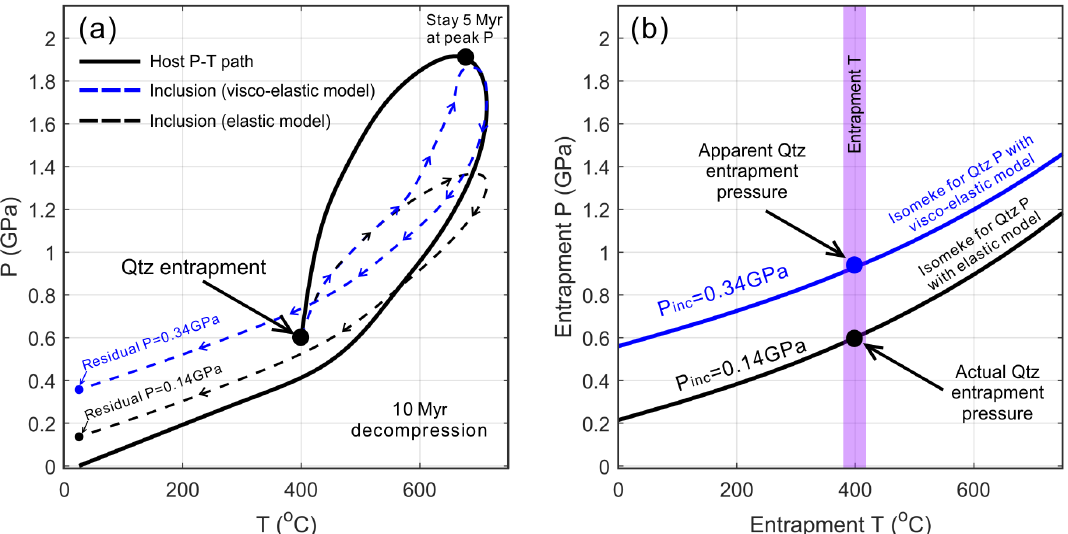
Figure 6. (a) Clockwise P – T path of inclusion (dashed curve) and host (solid curve). The dashed black curve shows the inclusion P – T path based on a pure elastic model, and the blue dashed curve is based on a visco-elastic model. The quartz inclusion is entrapped in almandine garnet at 400 ◦ C, 0.6GPa. The prograde P – T path lasts 5Myr, and the rock stays at peak P for 5Myr before the retrograde P – T path, which lasts 10Myr. The residual pressure preserved by the quartz inclusion that was subject to viscous relaxation is in fact higher than the elastic limit. Therefore, the apparent entrapment pressure, calculated using elastic isomeke, is higher than the actual entrapment pressure as shown in (a) . This may lead to a ca. 3–4kbar apparent overstepping effect. The almandine flow law is from Wang and Ji (1999).